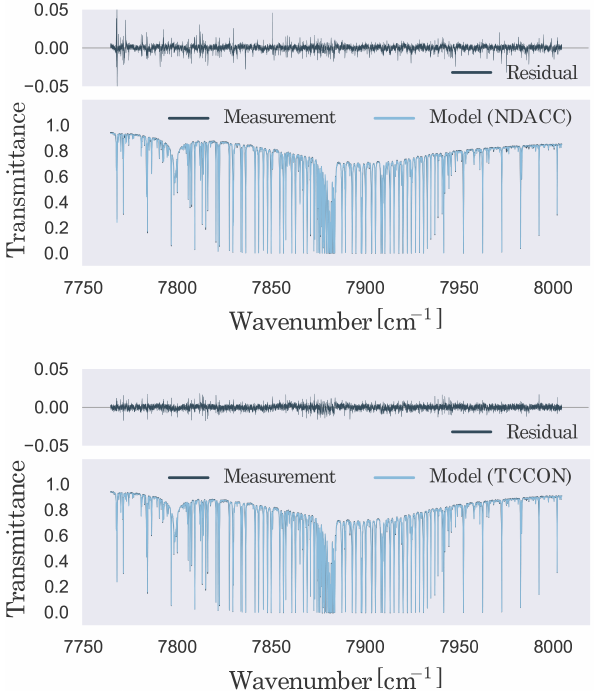
Figure 4. Spectral fits and residuals for one particular Karlsruhe spectrum recorded in the NIR for O 2 retrieved with PROFFIT (up- per panel) and GGG2014 (lower panel). Residuals in the NIR are smaller due to the adoption of H 2 O absorption line parameters in the line list used for the TCCON retrieval.